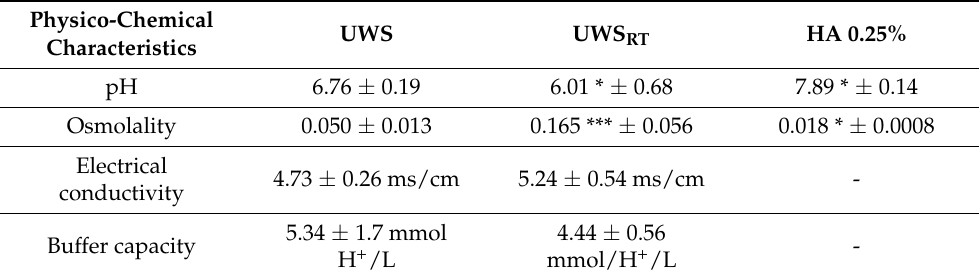
Table 1. pH value, osmolality, electrical conductivity and buffer capacity of unstimulated whole saliva (UWS) and UWS RT and hyaluronic acid (HA) 0.25% ( w / w ). Differences were evaluated significant at a level of p < 0.05, (*), and p < 0.001 (***). Physico-Chemical Characteristics